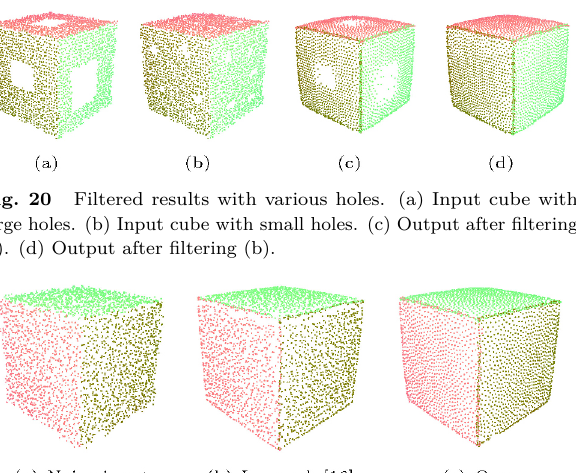
Fig. 19 Filtered results for an irregularly sampled point cloud.